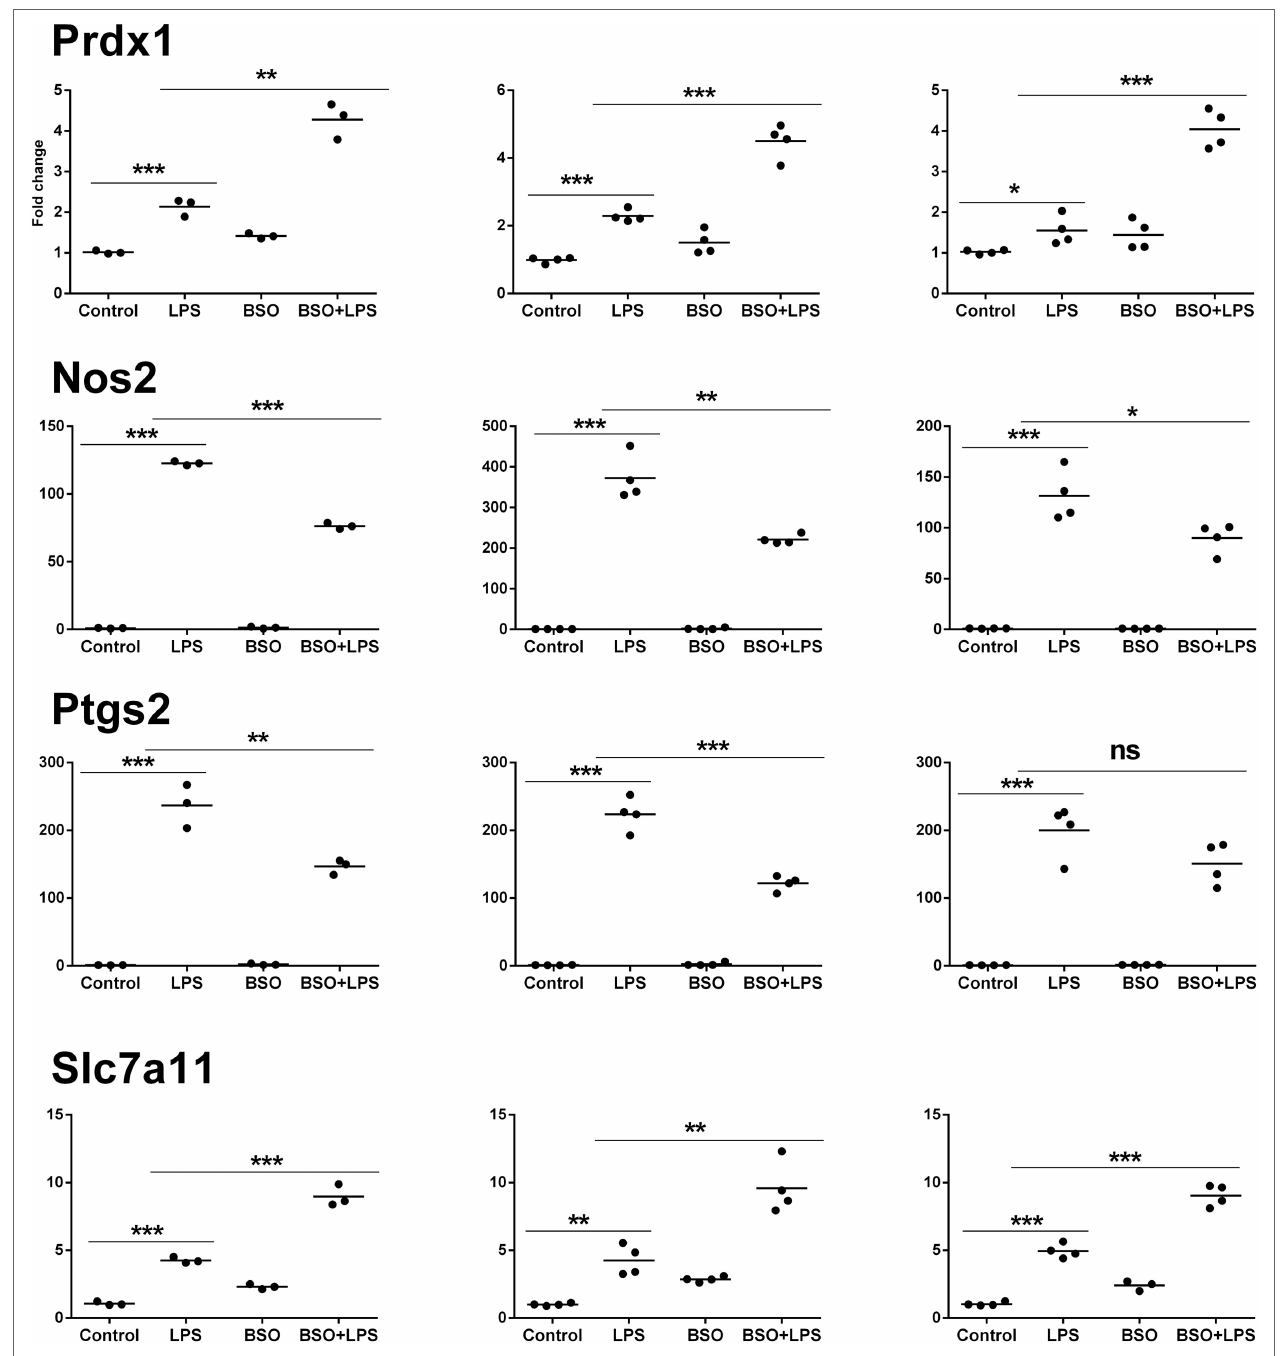
FigUre 7 | PCR validation of the microarray data at 6 h. Results for four genes (Prdx1, Nos2, Ptgs2, Slc7a11), comparing expression data from microarrays ( N = 3 biological replicates; left graphs) with results from PCR analysis using all the four replicates of the RNA from the same experiment ( N = 4 biological replicates; middle graphs) and RNA from an independent experiment ( N = 4 biological replicates; right graphs). Data are expressed as fold change vs one of the respective control samples. For each experimental group, the mean is also shown. * P < 0.05, ** P < 0.01, and *** P < 0.001 by two-tailed Student’s t -test. PCR, polymerase chain